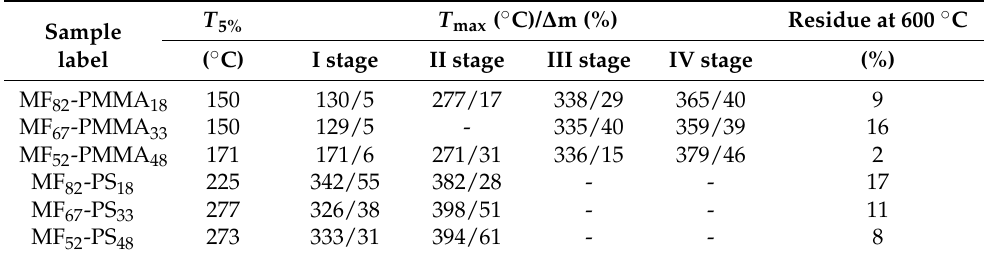
Table 3. Thermal parameters obtained from TG and DTG curves of microcapsules